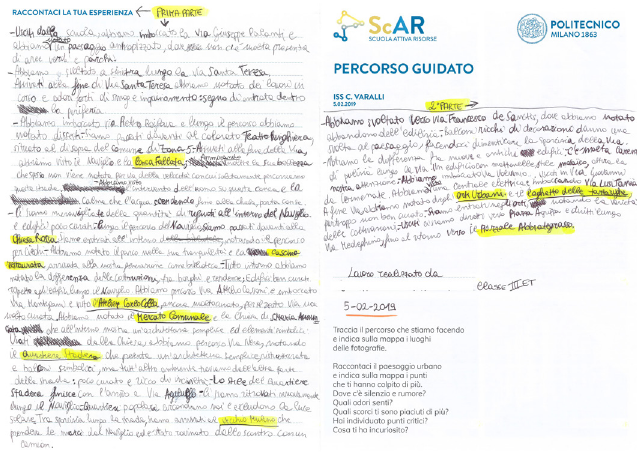
Fig. 6 The considerations a group of students reported during the learning